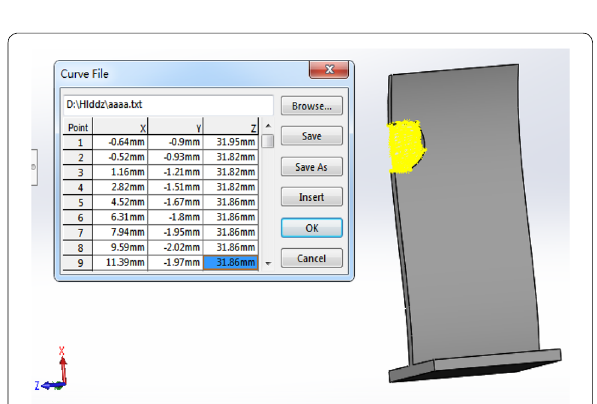
Figure 21 Laser cladding processing path